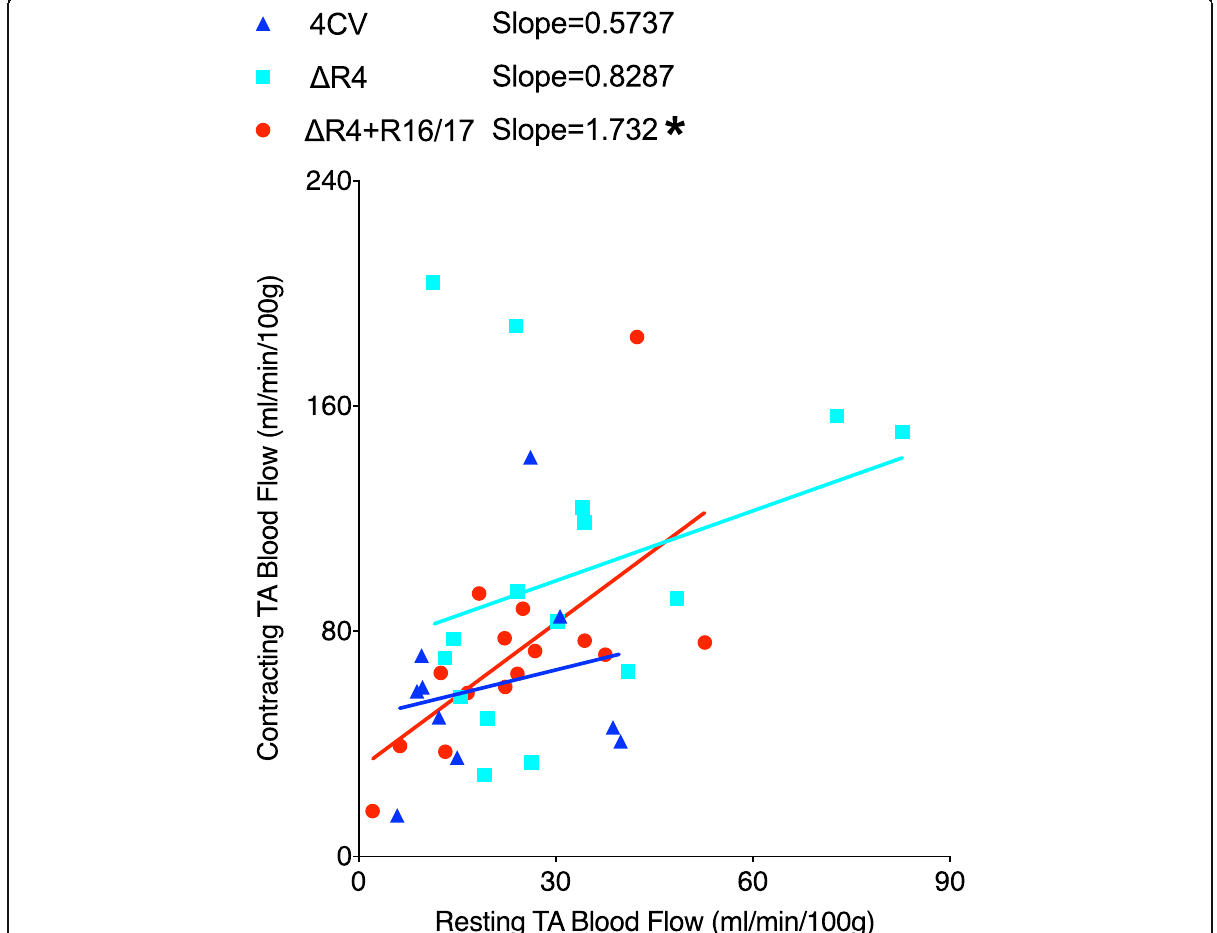
Fig. 6 R16/17 protein transfer improves blood perfusion of the contracting muscle. Blood flow of the TA muscles was measured by microsphere deposition and the flow probe reading. The linear regression model was established by plotting the values from the contracting muscle against those from the resting muscle. Statistical analysis was performed to compare the slopes of three experimental groups: mdx4cv mice , Δ R4 mice without R16/17 protein transfer and Δ R4 mice with R16/17 protein transfer. *: Δ R4 mice treated with R16/17 protein showed a slope that was significantly higher than the other two groups, indicating improved perfusion in the contracting TA muscle in this group of